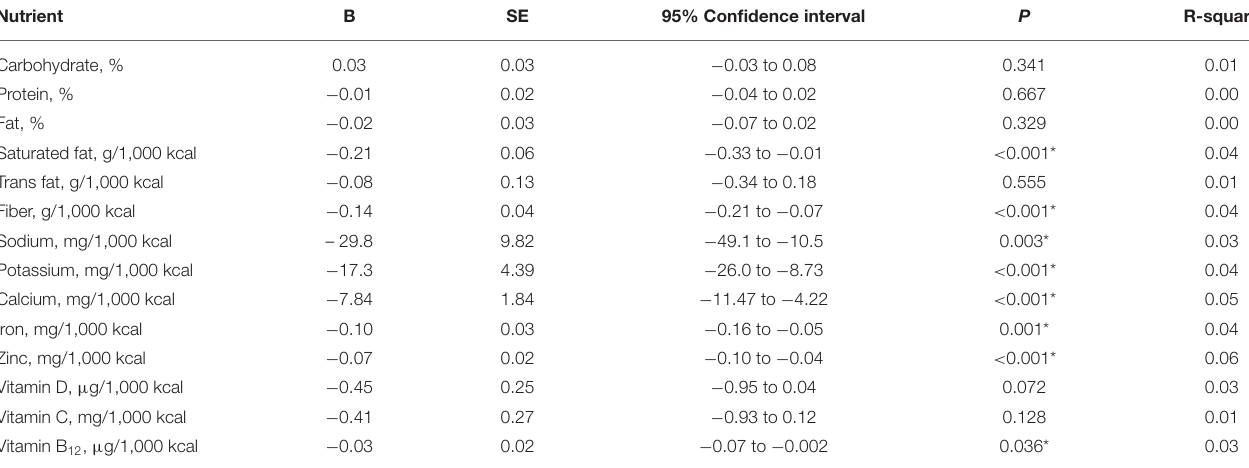
TABLE 3 | Multiple linear regression analysis of the association between children’s nutrient intake and percent of free sugar intake. Nutrient B SE 95% Confidence